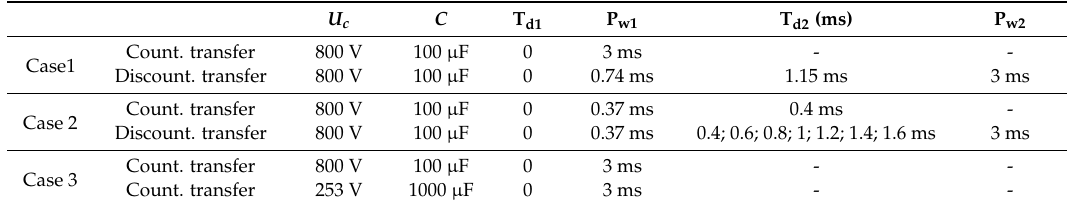
Table 2. Switch parameters for the examined